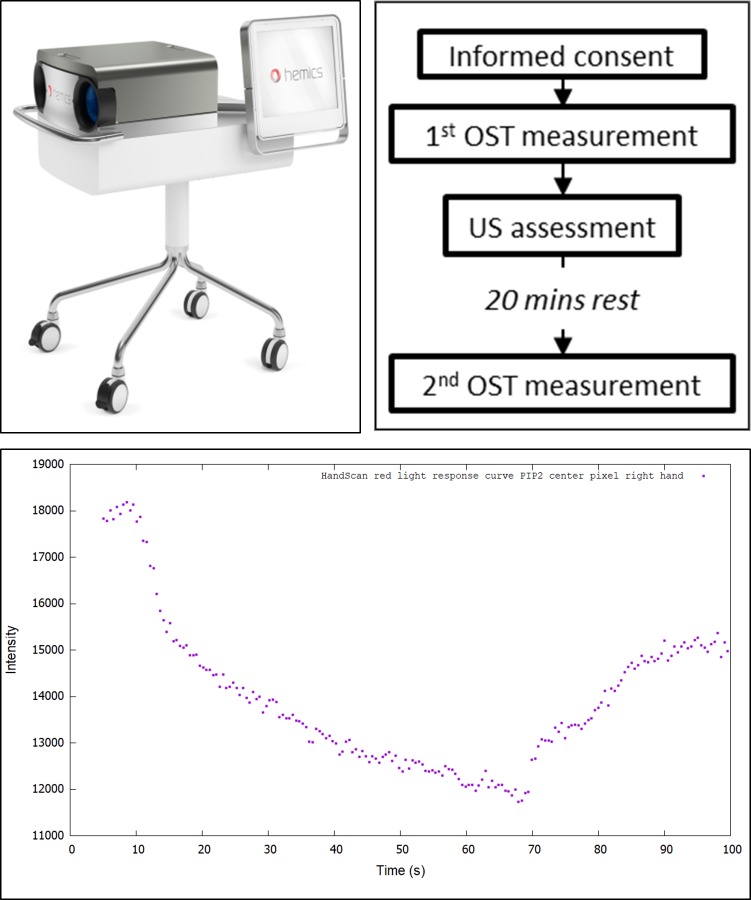
A) The HandScan apparatus. B) Data on the hemodynamic response to venous occlusion that are derived from light transmission data (described in more detail previously [9]). C) The study procedure for US and OST assessment.